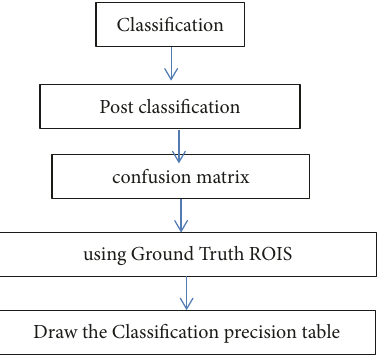
Figure 8: Flowchart of accuracy